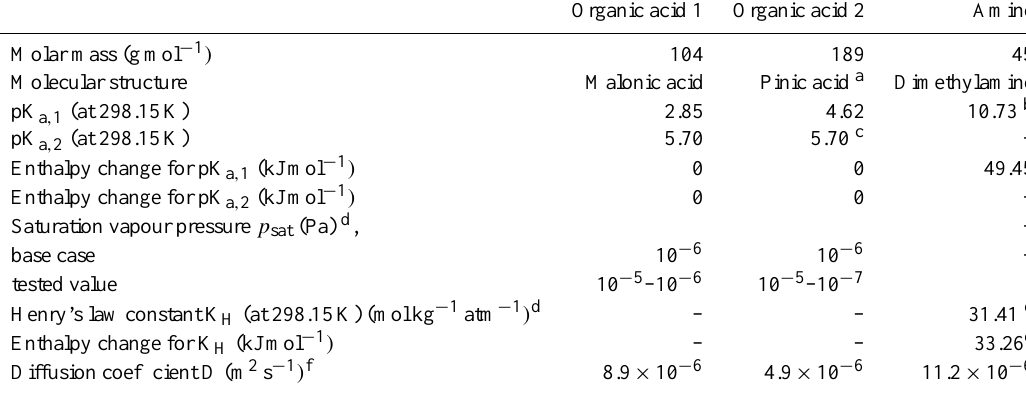
Table 1. Properties of organic compounds used in the